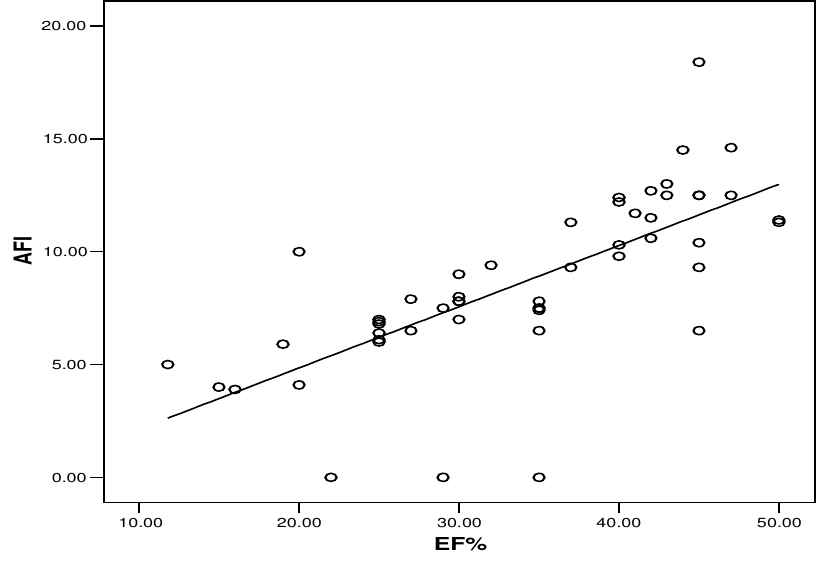
FIGURE 7. Correlation between EF% and AFI (GLPSS) among DCM